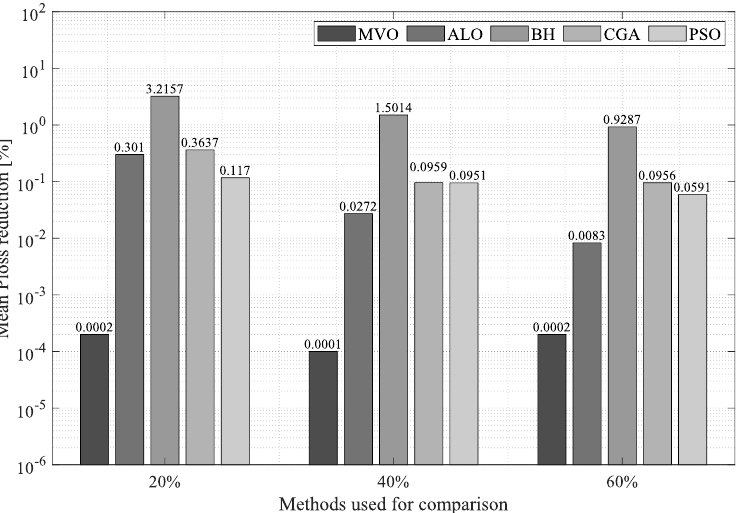
Figure 4. Percentage of reduction in average power losses obtained by the SSA in the 21-node system compared to that of the other